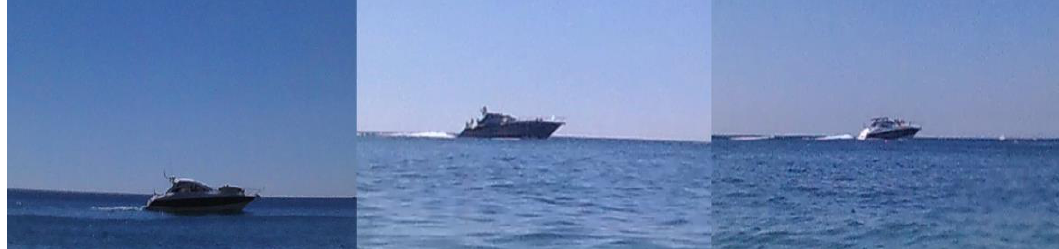
Figure 6. ( a ) Juvenile specimen of Larus michahellis (Naumann, 1840). ( b ) Nesting areas in the cliffs.